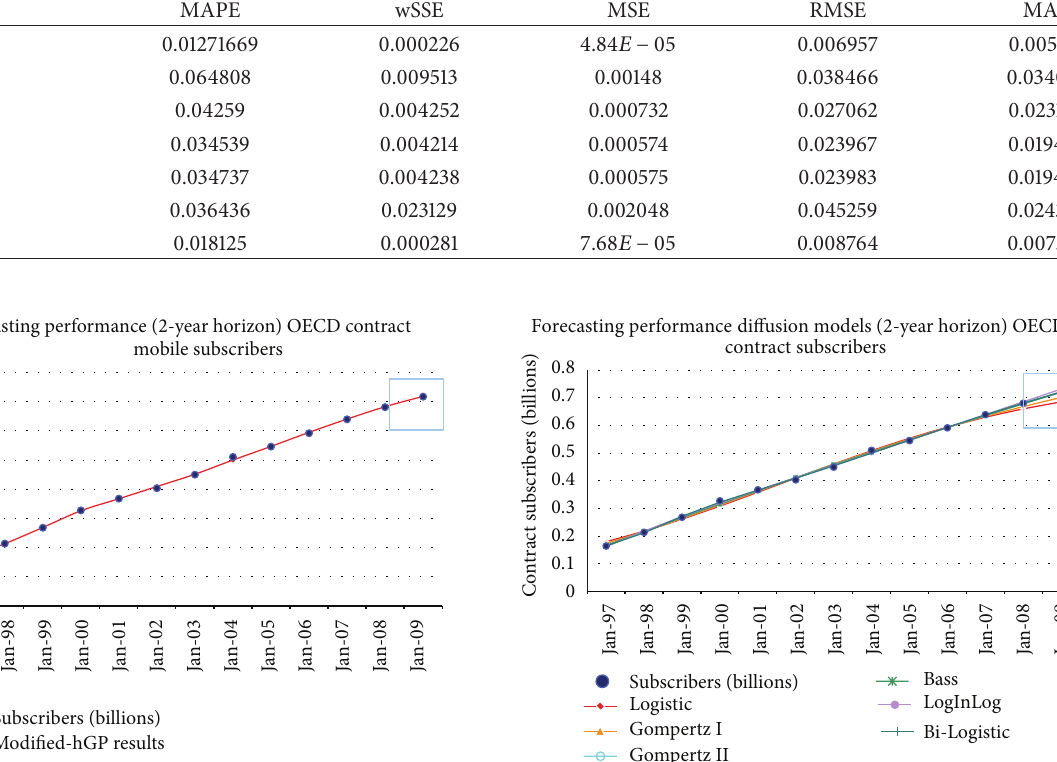
Table 7: Statistical indices in forecasting process of the modified-hGP and diffusion models for the total number of OECD subscribers. Statistical indices of the modified-hGP and diffusion models in forecasting the total number of OECD mobile subscribers